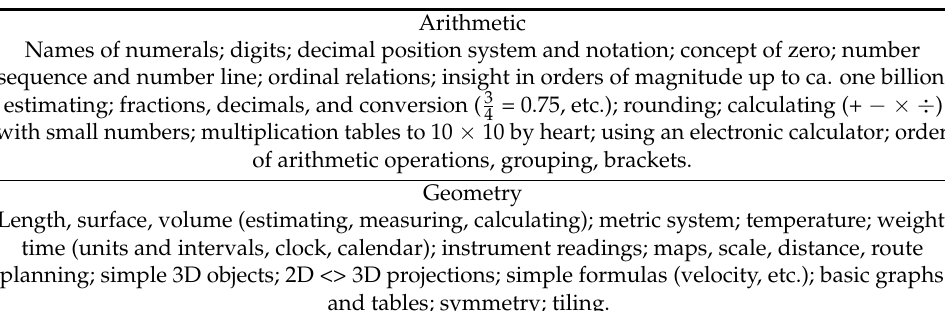
Table 1. Global educational objectives for mathematics at the end of primary school in the Nether- lands. Extracted from